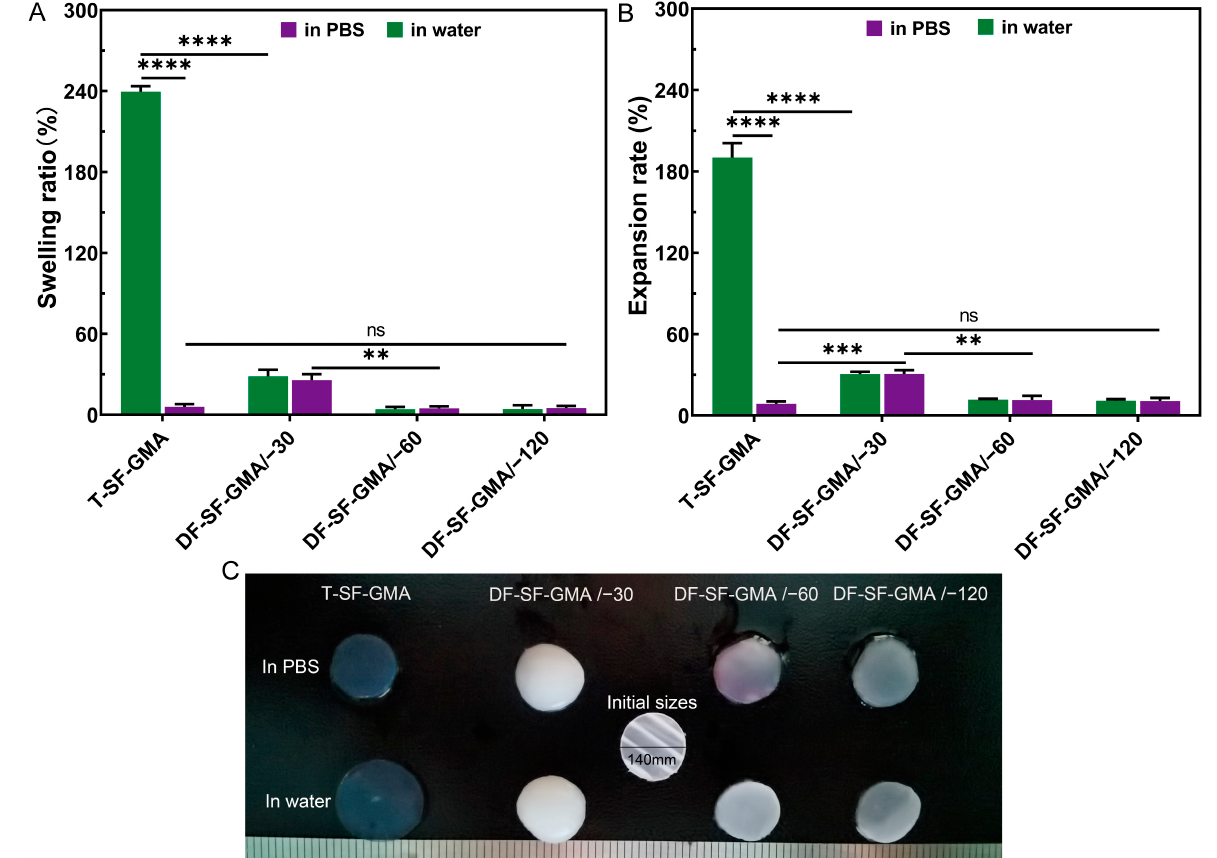
Figure 6. The ( A ) swelling ratio and ( B ) expansion rate of the T-SF-GMA and DF-SF-GMA hydrogels in PBS and milli-Q water. ( C ) Photomicrographs of all the hydrogels after swelling for 24 h (** p < 0.01; *** p < 0.001; and **** p < 0.0001, n = 4).